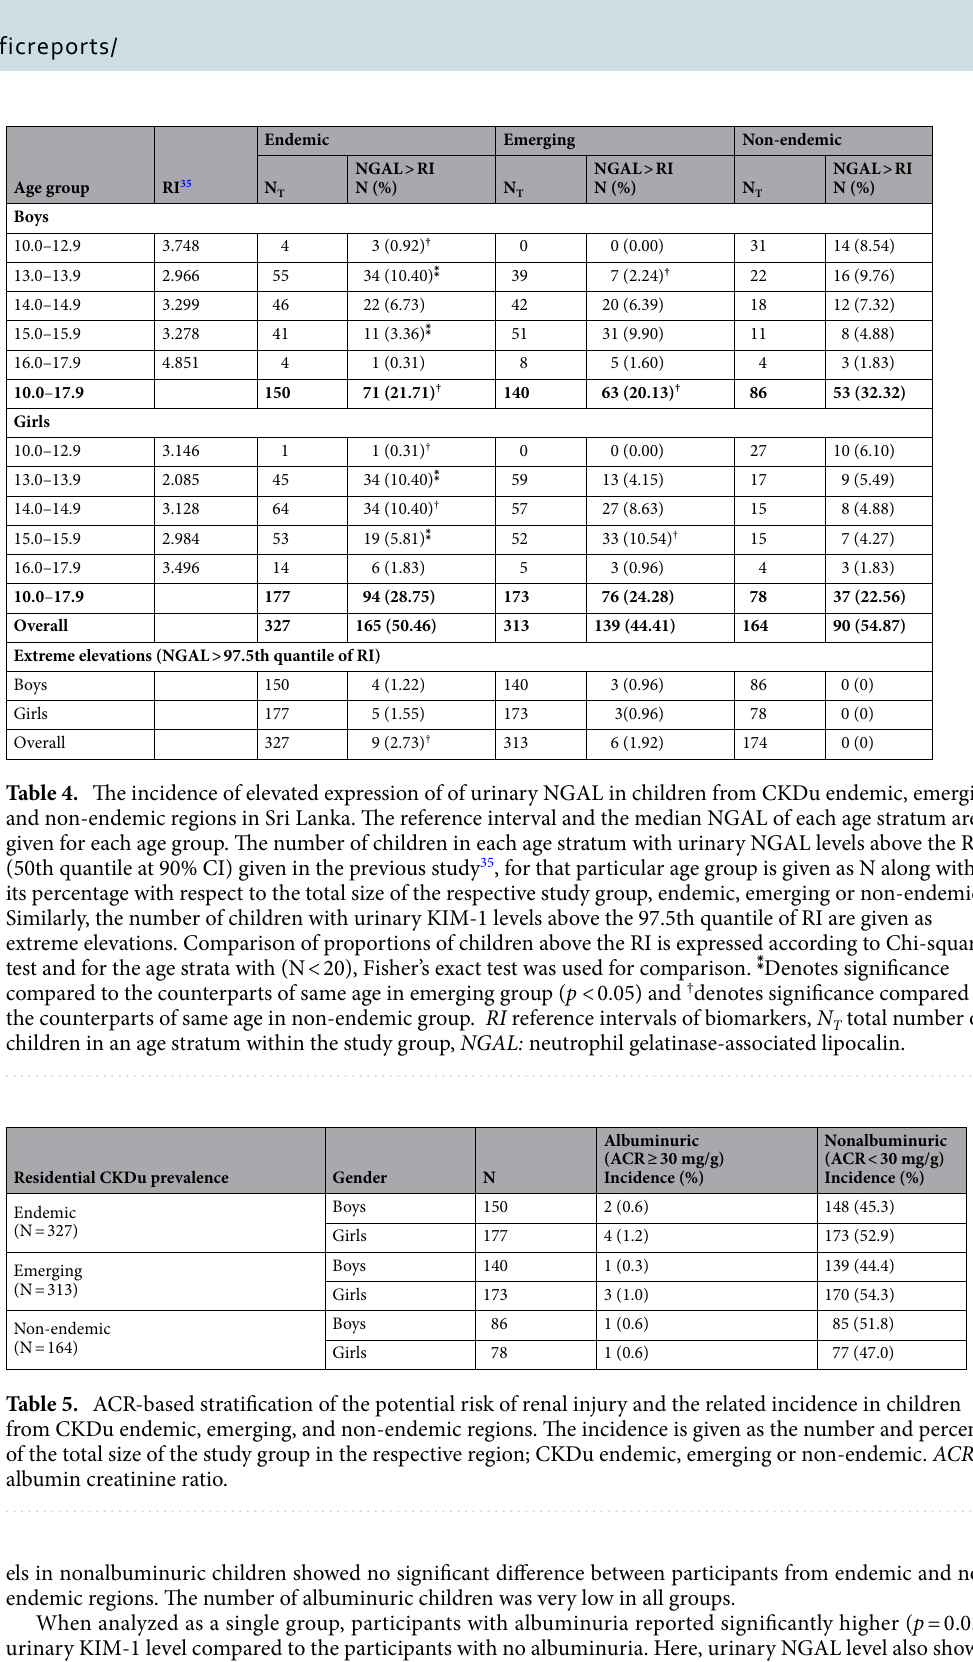
els in nonalbuminuric children showed no significant difference between participants from endemic and non- endemic regions. The number of albuminuric children was very low in all groups. When analyzed as a single group, participants with albuminuria reported significantly higher ( p = 0.032) urinary KIM-1 level compared to the participants with no albuminuria. Here, urinary NGAL level also showed no significant difference between the albuminuric and nonalbuminuric groups ( p = 0.334). Within the context of findings, urinary KIM-1 expression demonstrated profound differences across the three regions showing elevated expression in participants with increasing prevalence of CKDu in residential areas. Also, urinary KIM-1 showed elevated expression in albuminuric children. On the contrary, urinary NGAL did not demonstrate noteworthy variations with residential CKDu prevalence or albuminuria. As such, KIM-1 appears to be a more sensitive marker that indicates potentially low-grade renal injury in children, where the